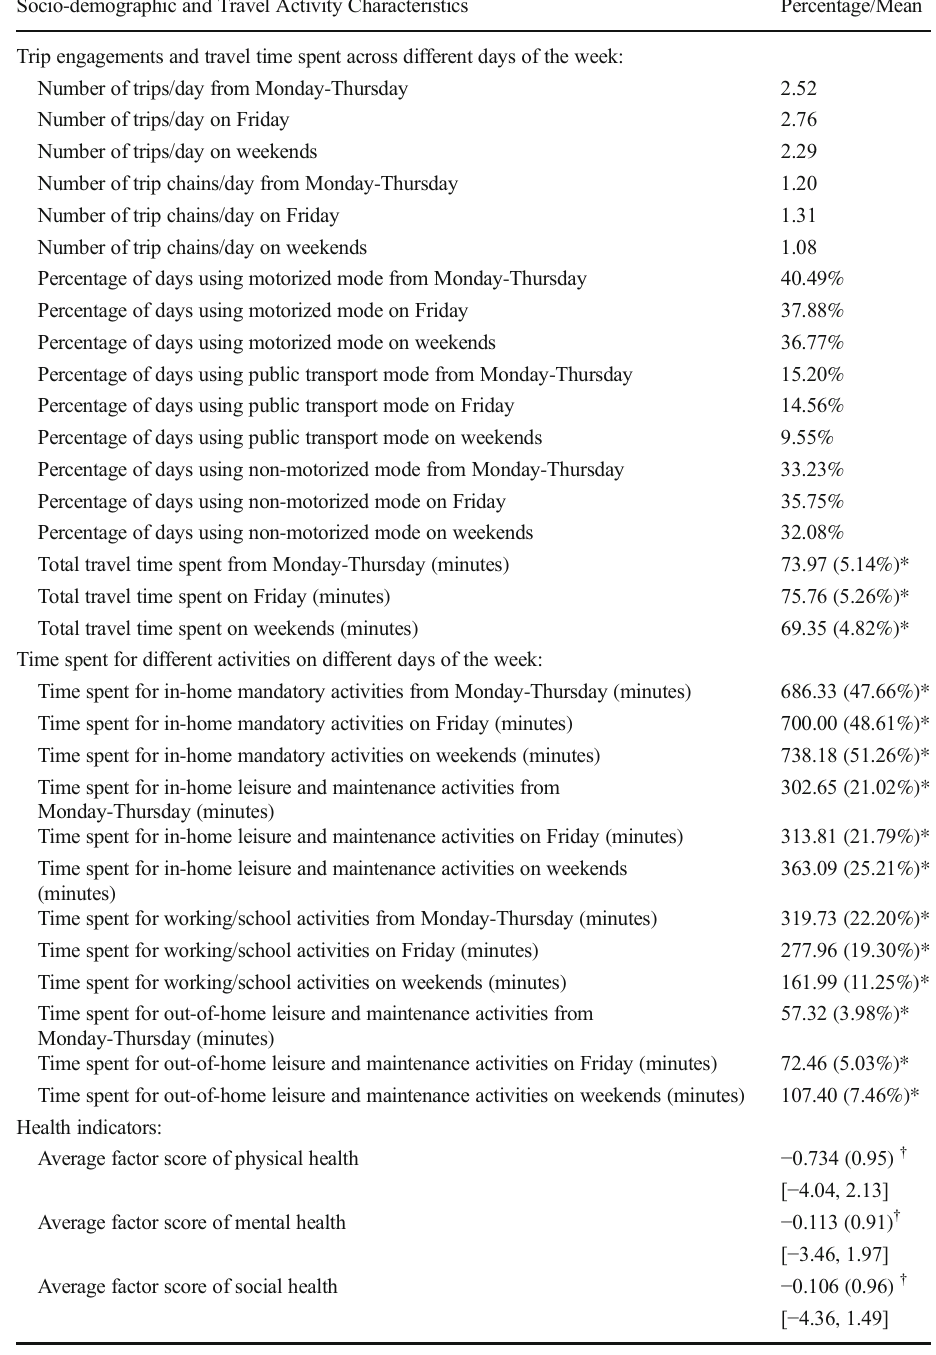
Table 2 Profiles of the samples used in the study Socio-demographic and Travel Activity